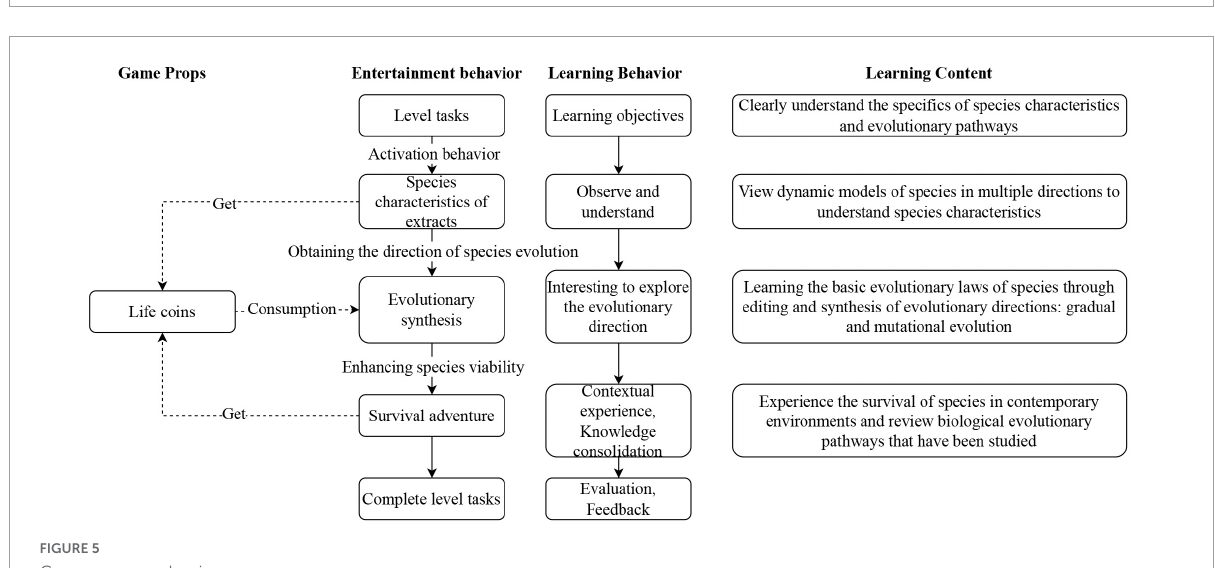
FIGURE5 Core game